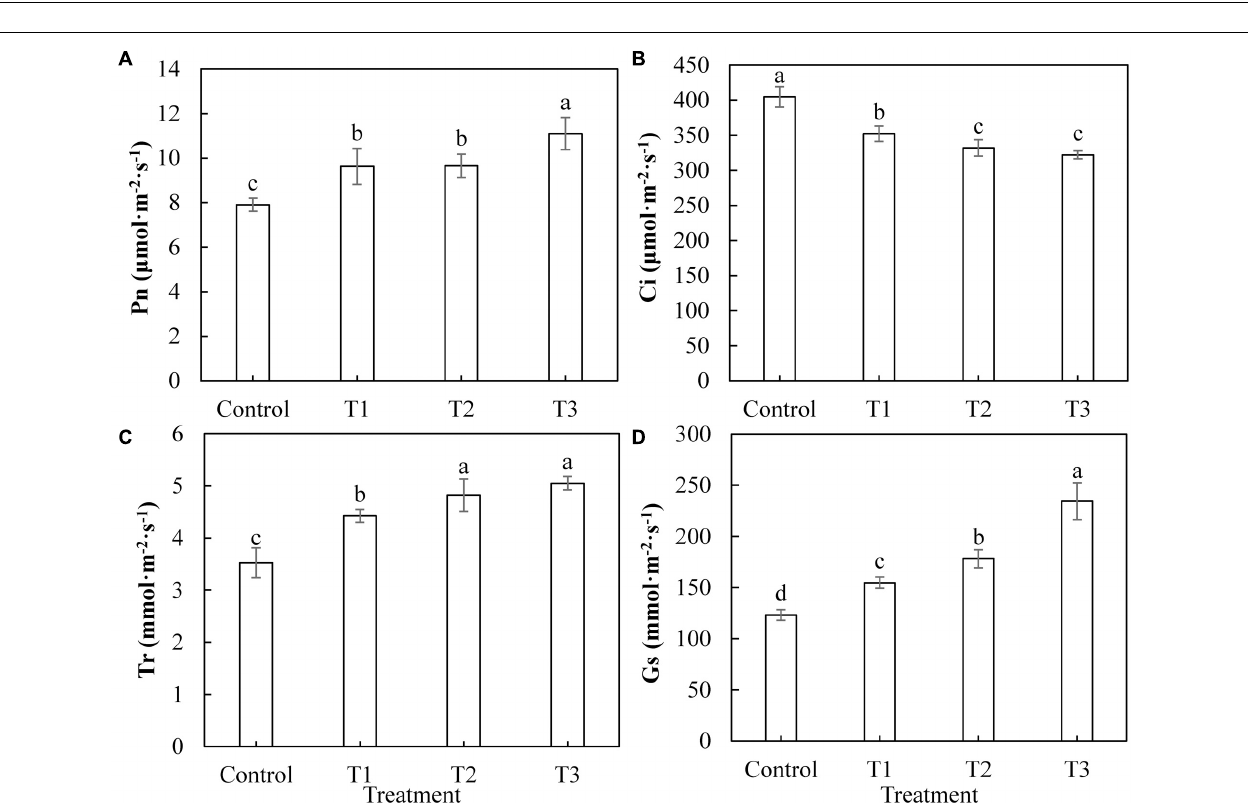
FIGURE 3 | Effect of supplemental LED light duration on fresh weight (A) and dry weight (B) of cucumbers. The dry matter accumulation of cucumbers was measured on 30 days after supplemental LED light treatment. Nine cucumber plants with the same height were selected from each treatment. Values are expressed as the mean ± SE ( n = 3). Bars that are significantly different based on the Duncan’s multiple range test ( p < 0.05) are indicated with different lowercase letters.